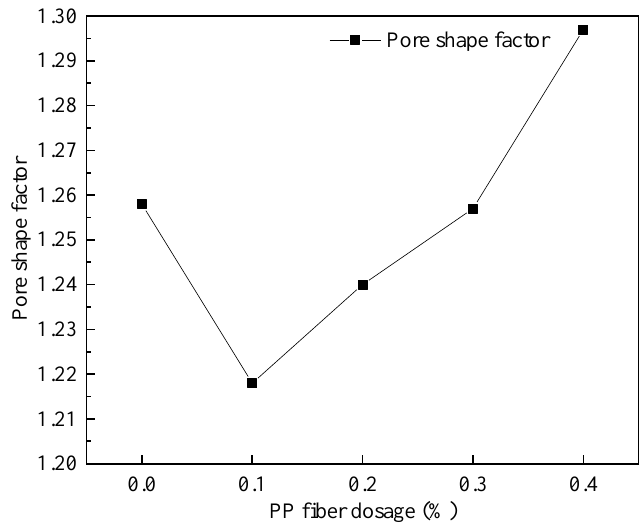
Figure 24. Effect of fiber doping on pore shape factor.